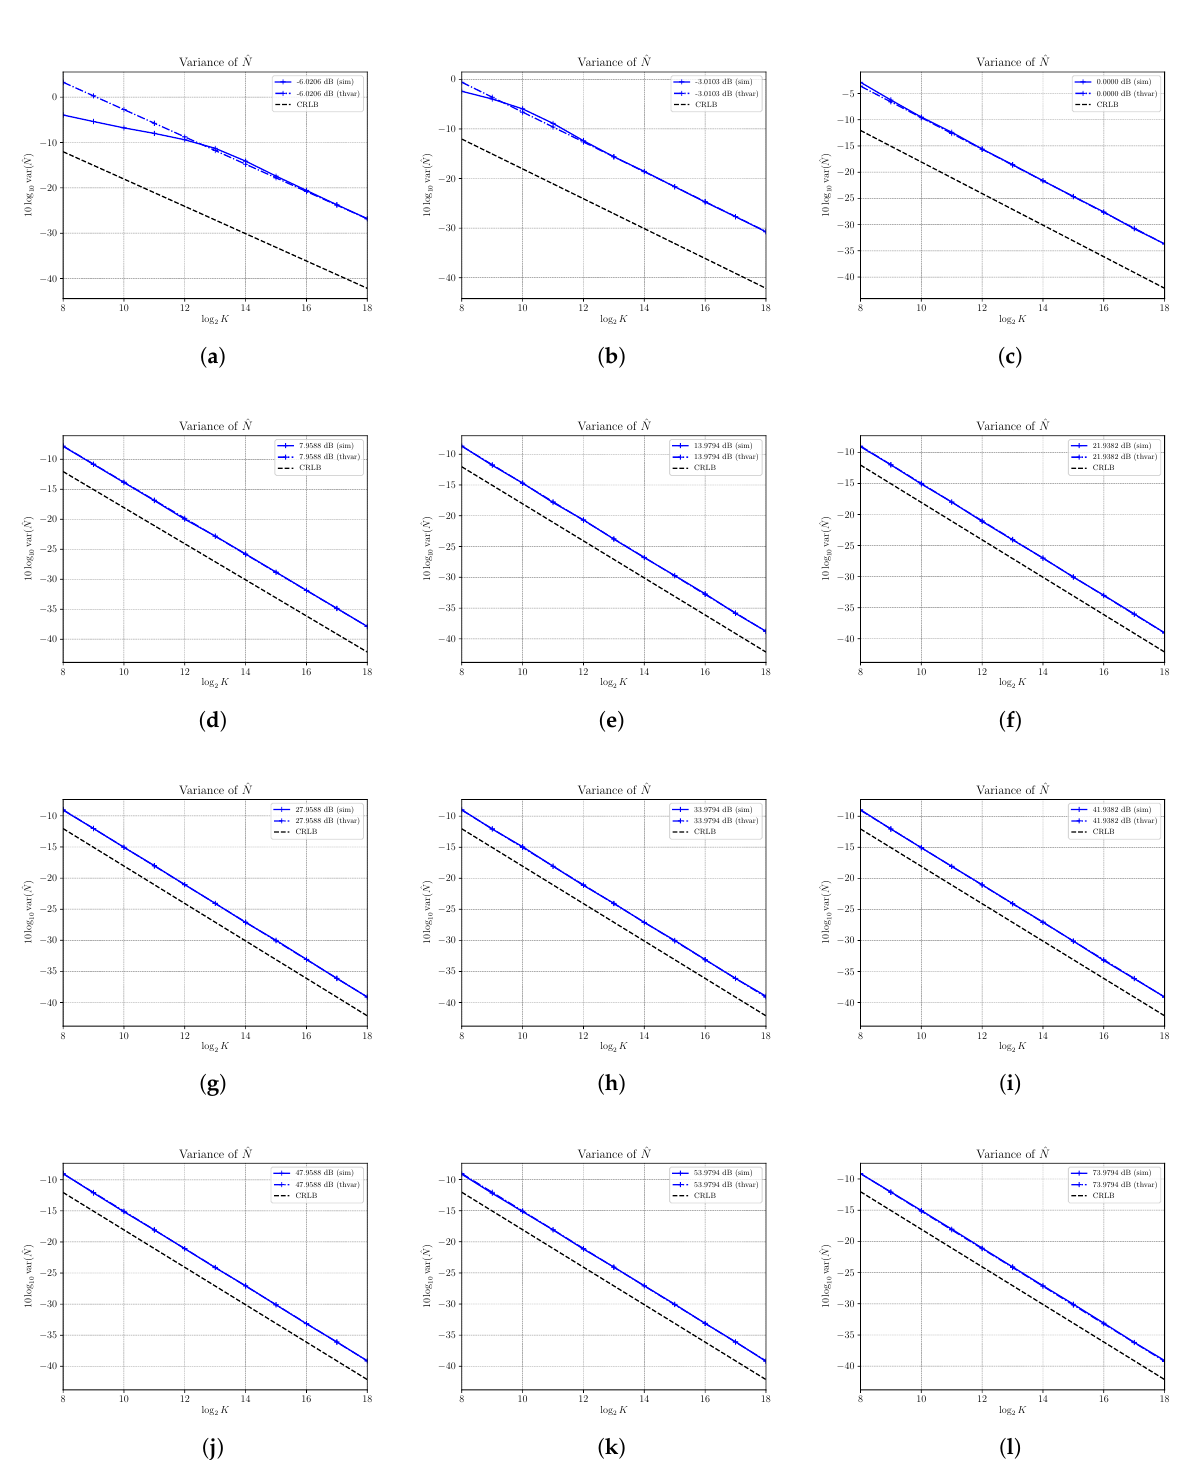
Figure 6. Asymptotic and estimated variances of the noise power estimator ˆ N versus the number of observations K . Each sub figure ( a – l ) shows results for a given nominal value of SNR obtained by changing the signal power S and with noise power N =